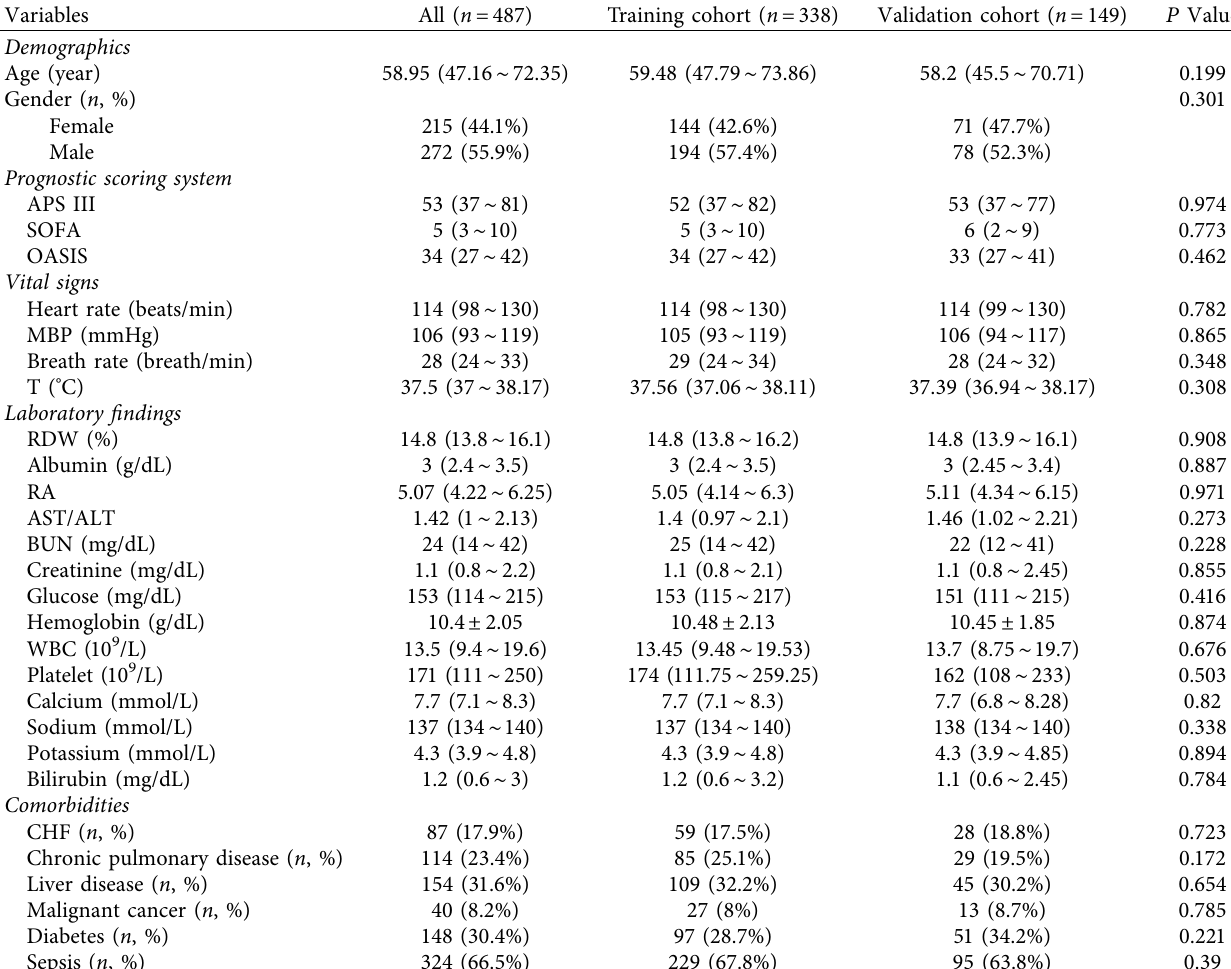
Table 1: Baseline characteristics of patients with acute